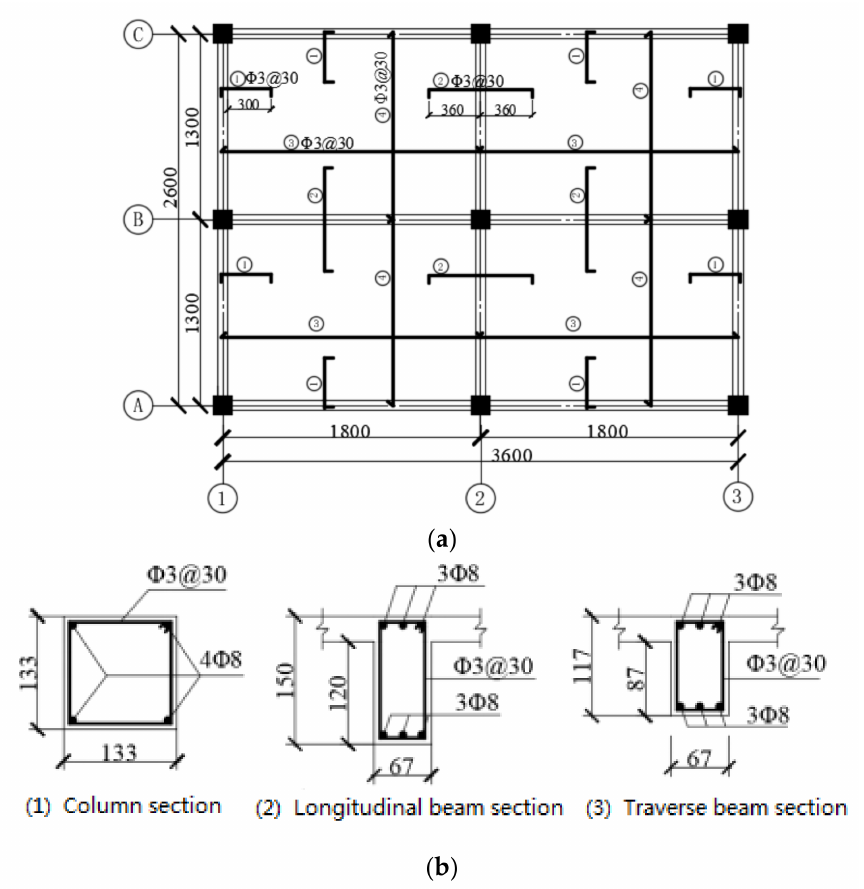
Figure 3. Details of slabs, beams and columns, ( a ) layout of slab reinforcing bars, ( b ) layout of beam and column reinforcing bars.